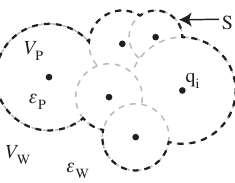
Figure 1 The basic molecular electrostatics problem: the solute mol- ecule (e.g., a protein) is modeled as a homogeneous macroscopic dielectric medium whose volume V tion of atomic spheres; the permittivity is ε distribution is frequently modeled as discrete point charges at the atom centers. Consequently, the potential in V equation. The solute is embedded in an infinite solvent bath, V is modeled as a homogeneous dielectric with permittivity ε the potential obeys either a Laplace equation (in pure water) or the linearized Poisson-Boltzmann equation (in a dilute